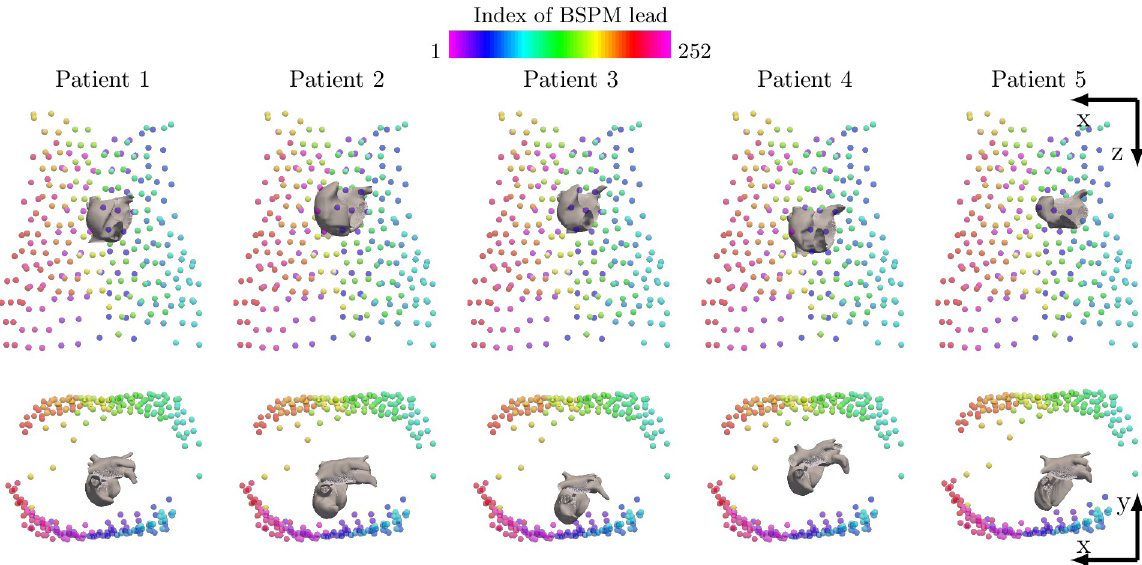
Fig 6. Meshes of five patient atria, and locations of 252 vest leads to compute BSPMs. Each column shows the data for one patient. The top row shows the front view and the bottom row shows the top view. Inter-patient variations of atrial shapes and positions are visible.